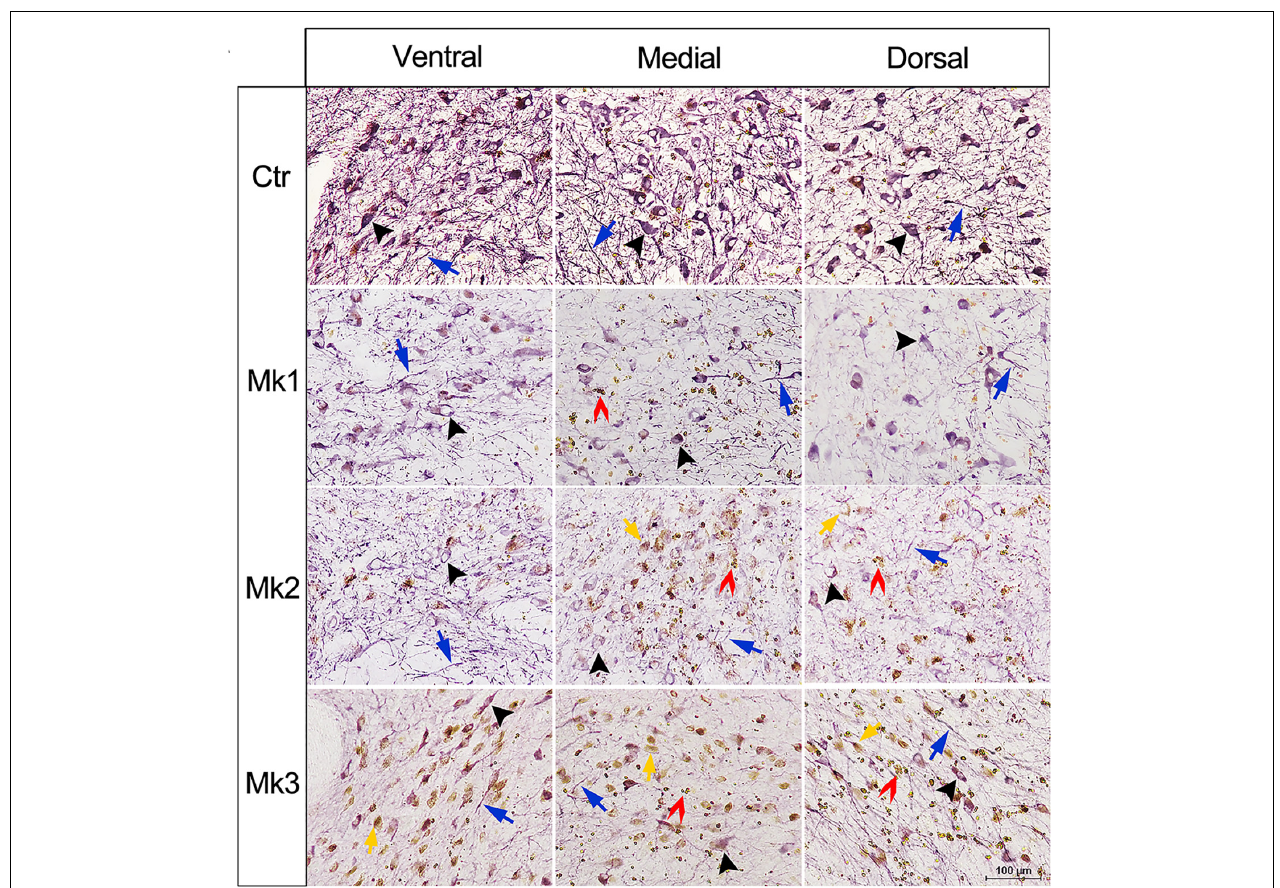
FIGURE 3 | Micrograph of immunohistostaining of TH + neurons in the SN regions of control and MPTP-injected monkeys. Immunohistostaining of Tyrosine hydroxylase (TH) in the SNc in control and MPTP-lesioned monkeys. The images were taken from ventral, medial, and dorsal area of the SN for all involved monkeys. Black arrows indicate the neuronal soma and blue arrows denote neurites with positive TH (+) staining. In MPTP-lesioned monkeys, both neuronal somas and neurites were damaged, and the damage in Mk3 is more obvious than Mk2 and Mk1. In addition, brown dots were detected in soma (yellow arrows and inset) and in the extracellular (red arrows and